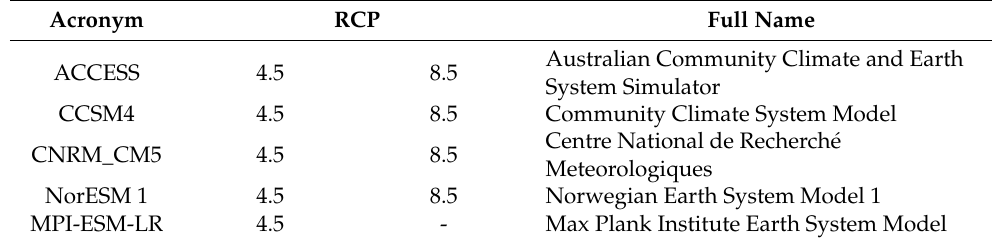
Table 2. Details of RCM